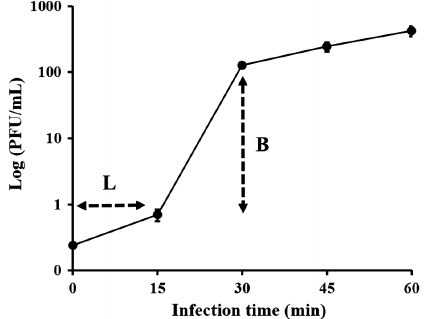
Figure 3. One-step growth curve of Enteroc21. L, latent period; B, burst period. Data are presented as the mean ± standard deviation.